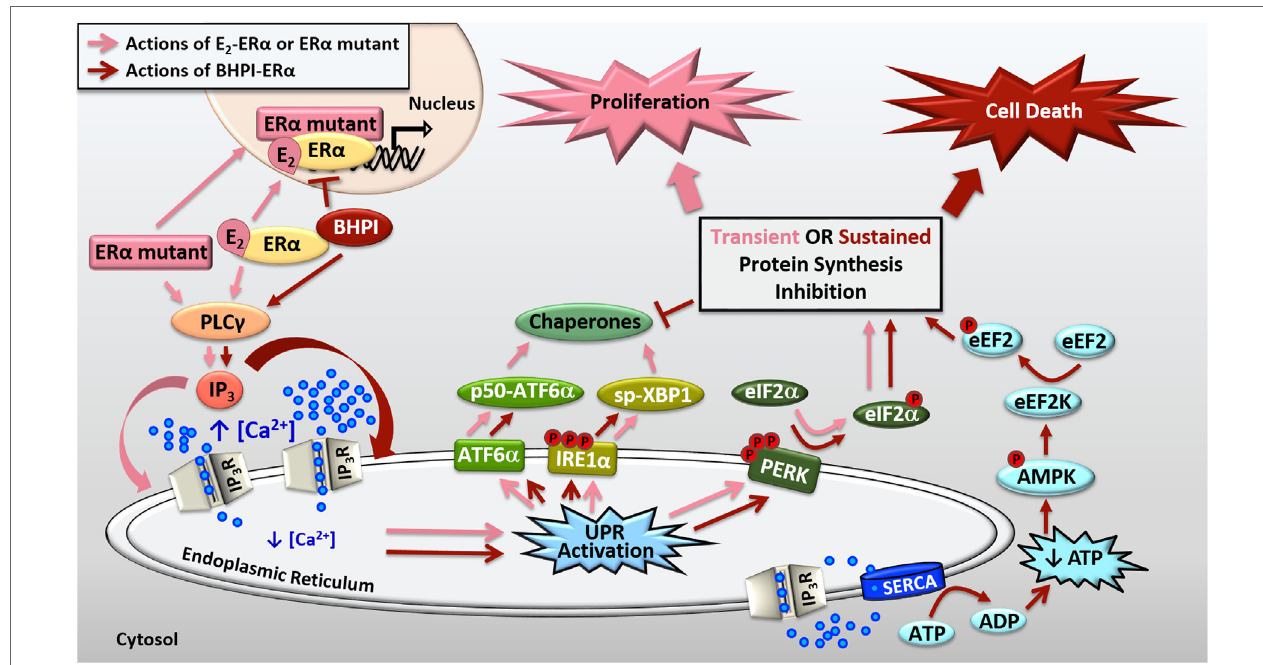
FiGURe 2 | Activation of the anticipatory unfolded protein response by estrogen receptor α (ER α ). E 2 -ER α and constitutively active ER α mutants activate a mild and protective anticipatory unfolded protein response (UPR) and the non-competitive biomodulator BHPI binds ER α and induces hyperactivation of this pathway leading to cell death. ER α indirectly activates phospholipase C γ (PLC γ ), resulting in cleavage of PIP 2 to DAG (diacylglycerol) and IP 3 (inositol triphosphate). E 2 -ER α and constitutively active ER α mutants cause moderate IP 3 production, whereas BHPI causes significantly more production of IP 3 . The IP 3 then binds to IP 3 receptors (IP 3 Rs) in the endoplasmic reticulum (EnR) membrane, causing efflux of calcium from the lumen of the EnR into the cell body. E 2 -ER α and constitutively active ER α mutants cause moderate and transient release of calcium, resulting in weak and transient activation of all three arms of the UPR. Weak UPR activation results in very mild and transient inhibition of protein synthesis, production of molecular chaperones, and is critical for subsequent cell proliferation. BHPI-ER α induced hyperactivation of the UPR causes robust and sustained release of calcium from the EnR. This leads to robust PERK activation and rapid, sustained, and near-quantitative inhibition of protein synthesis. Although BHPI causes upregulation of chaperone mRNA, no protein is made, and the UPR-activating signal is never resolved. In an effort to re-establish cellular calcium homeostasis, ATP-dependent SERCA pumps in the EnR actively transport calcium back into the lumen of the EnR but since IP 3 Rs remain open, an ATP-depleting futile cycle ensues. Decreased cellular ATP and increased AMP activate AMPK, which along with calcium, activates Ca 2 + /calmodulin-dependent kinase, eukaryotic elongation factor 2 kinase (CAMKIII/eEF2K). eEF2K then phosphorylates eEF2, causing inhibition of protein synthesis at elongation. Ultimately, BHPI-ER α induced hyperactivation of the anticipatory UPR causes death of ER α positive endometrial and breast cancer